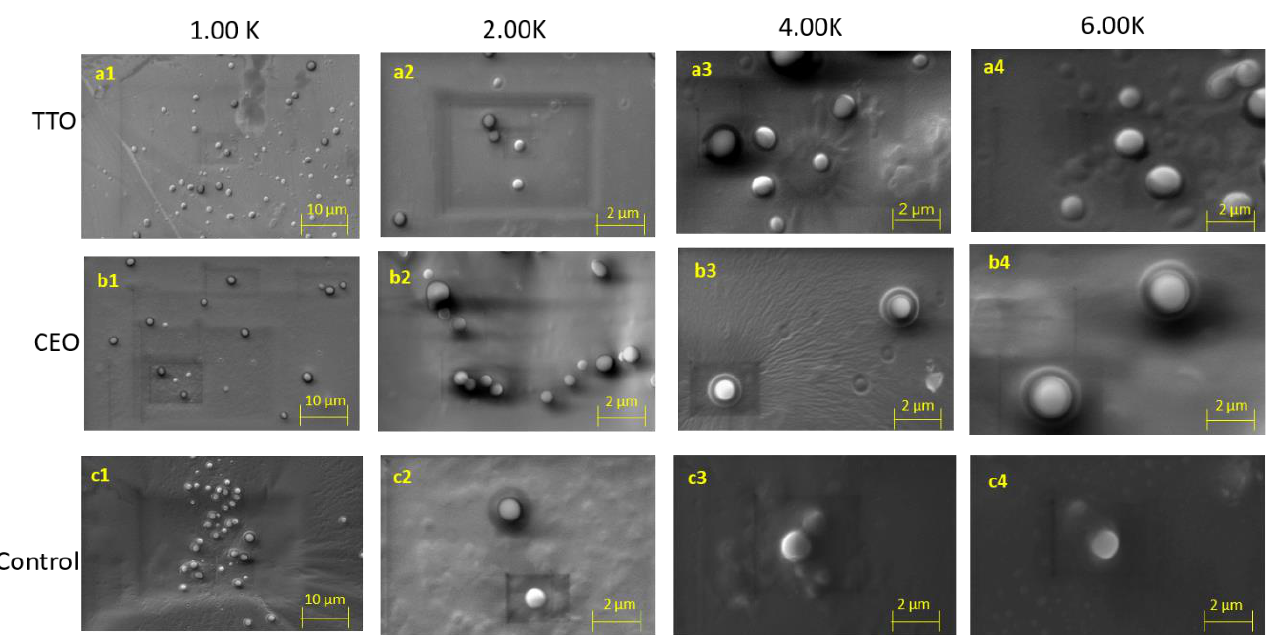
Figure 1. Representative scanning electron microscope images of TTO, CEO, and control samples ( a1 – a4 ) TTO, ( b1 – b4 ) CEO, and ( c1 – c4 ) control nanoliposomes at 1.0 K, 2.00 K, 4.00 K, and 6.00 K magnifications after storage at 4 °C.